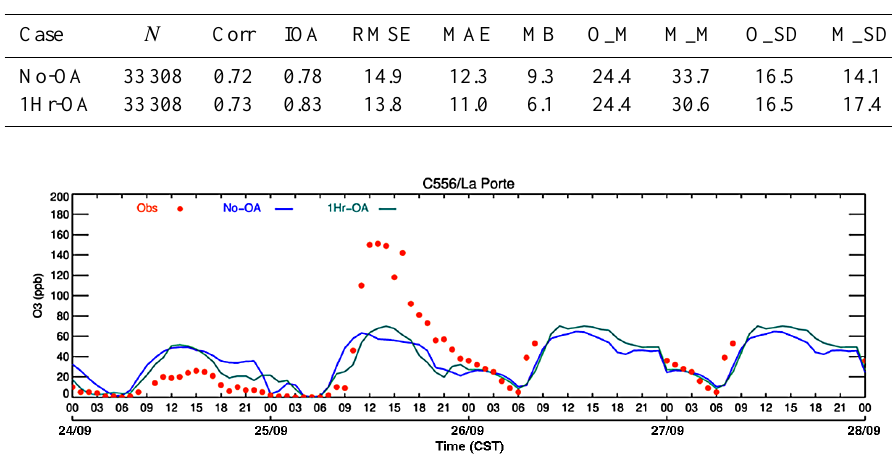
Figure 8. Ozone time series of La Porte (C556) between 00:00CST on 24 September and 00:00CST on 28 September 2013.